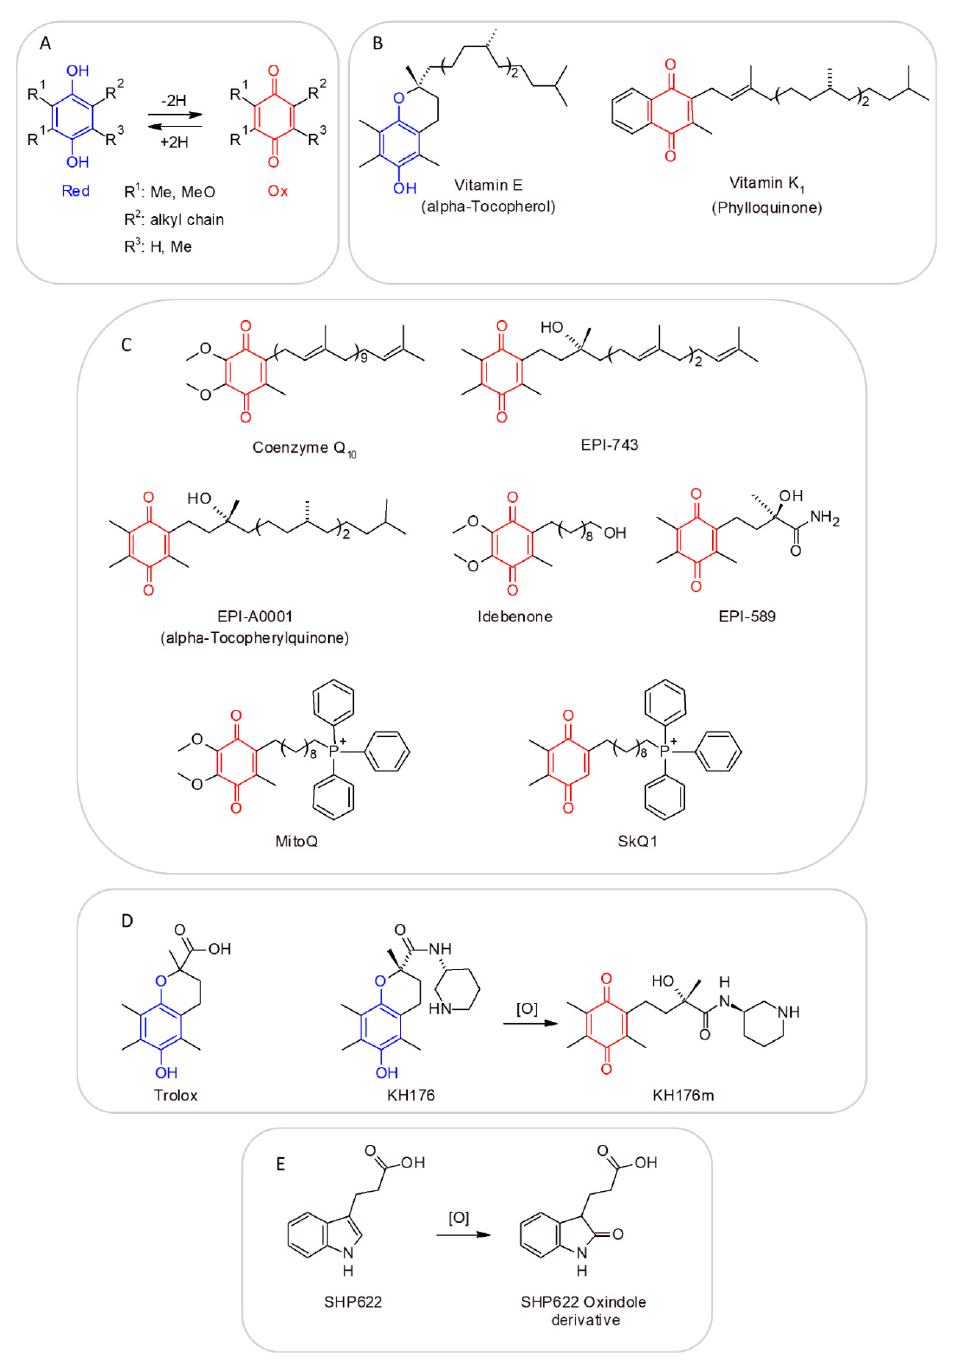
Figure 8. Chemical structures of compounds that are potentially useful as a pharmacological inter- vention for MDs. ( A ) General formula; ( B ) structures of vitamins E and K; ( C ) exemplary redox-active compounds; ( D ) KH176 as a Trolox analog and bioprecursor of KH176m; ( E ) SHP622, a peculiar antioxidant compound, and its oxidized product oxindole.